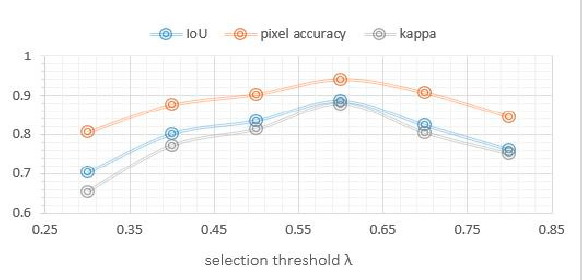
Figure 14. Effect of threshold parameter λ on accuracy. Figure 14. E ff ect of threshold parameter λ on